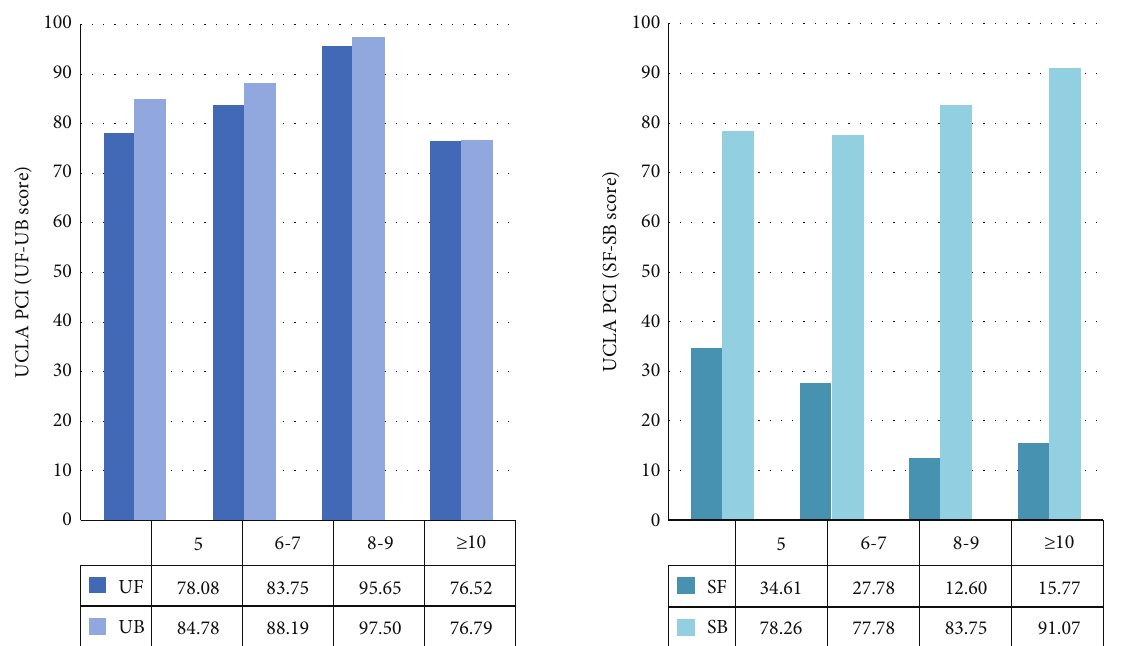
Figure 3: Comparison of function and bother in long-term disease-free survivors after nerve sparing RP without hormone treatment: UF: urinary function; UB: urinary bother; SF: sexual function; SB: sexual bother; RP: radical prostatectomy (adapted from